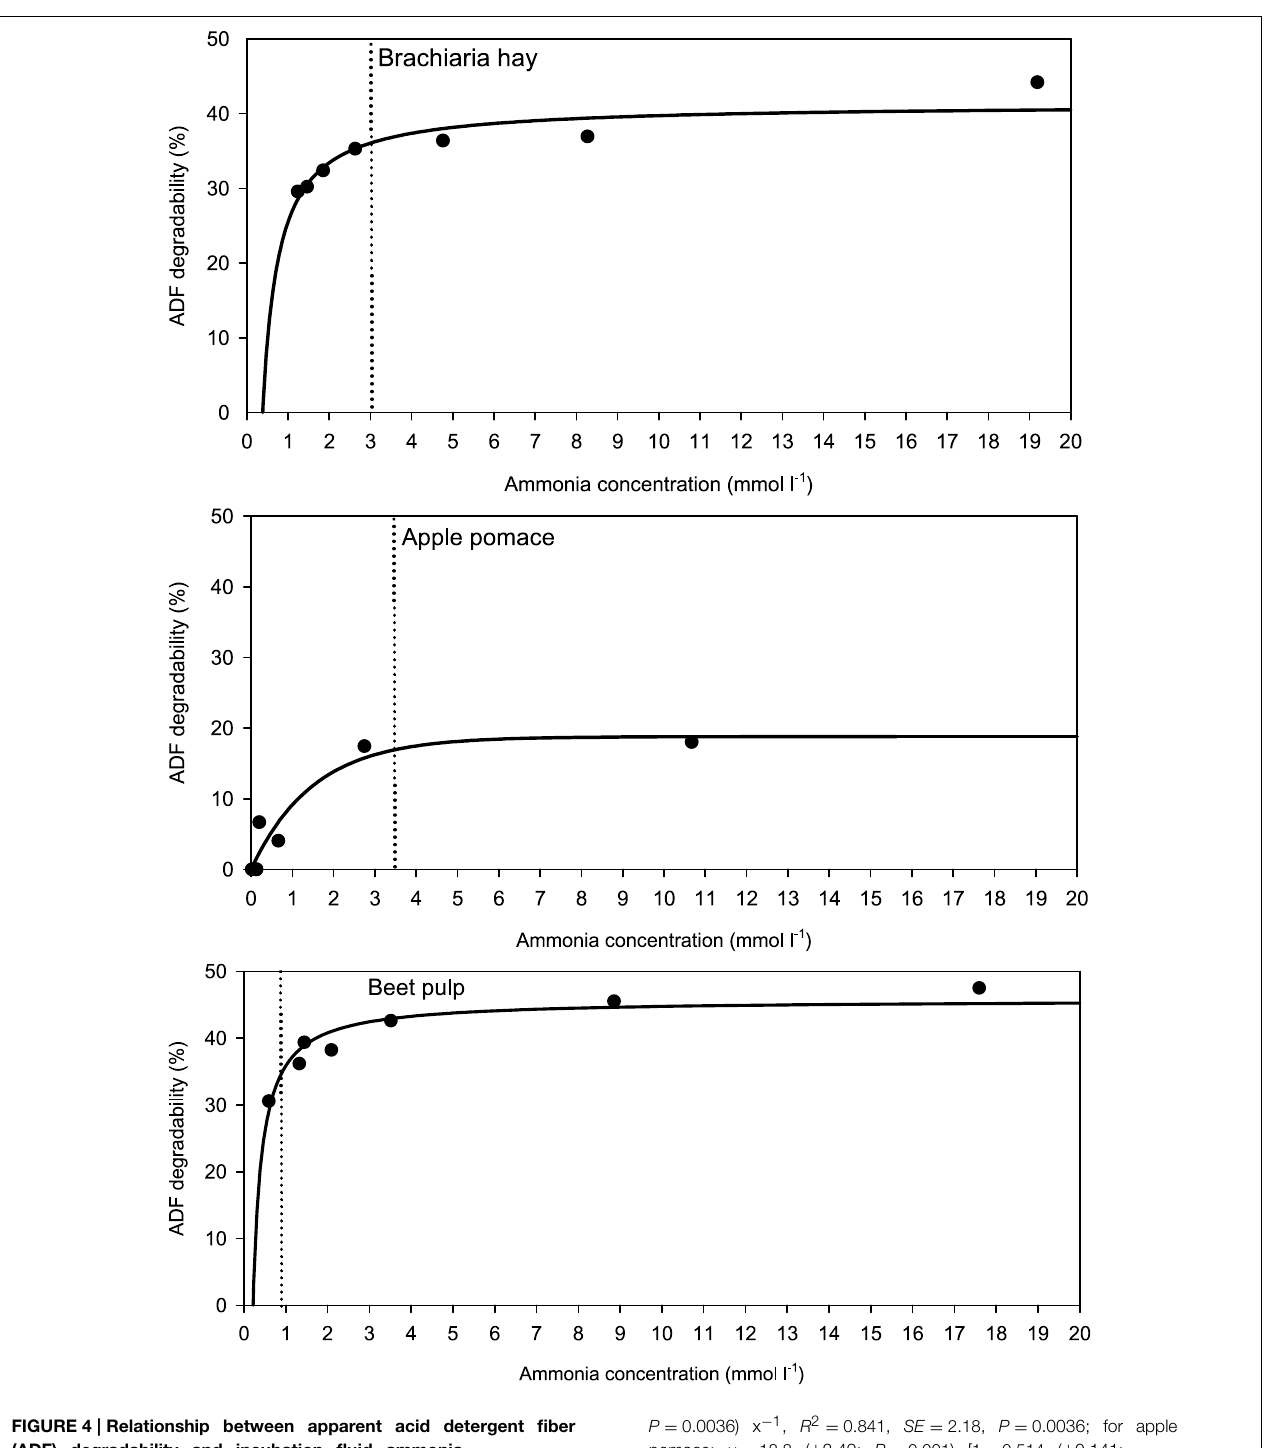
P = 0 .0036) x − 1 , R 2 = 0 . 841 , SE = 2 . 18 , P = 0 .0036; for apple pomace: y = 18 . 8 ( ± 2.49; P < 0 . 001 ) [ 1 − 0 . 514 ( ± 0.141; P = 0 .0147) x ], R 2 = 0 . 911 , SE = 2 . 61 , P < 0 . 001 ; for beet pulp: y = 45 . 8 ( ± 1017; P < 0 . 001 ) − 9.91 ( ± 1.51; P = 0 .0012) x − 1 , R 2 = 0 . 896 , SE = 2 . 04 , P = 0 .0012. The significance of the difference of response across fiber sources was P = 0 .064.